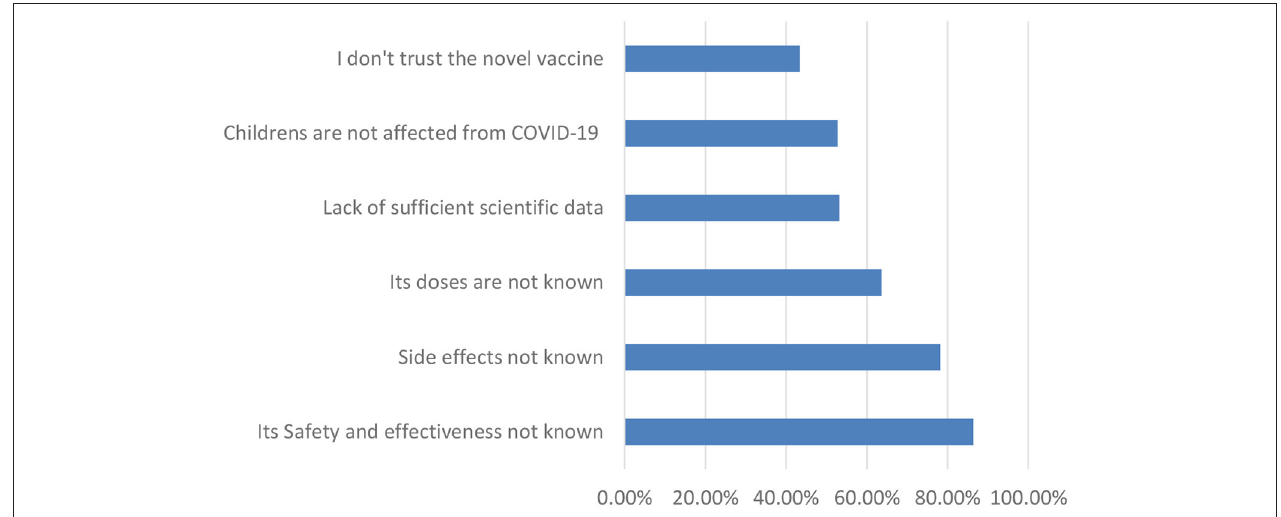
FIGURE 1 | Parents’ concerns for not willing to vaccinate of their children for COVID-19 ( n =